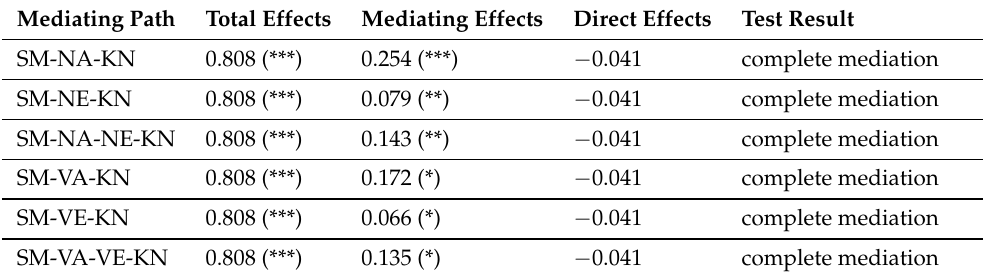
Table 7. Results of the mediating effect